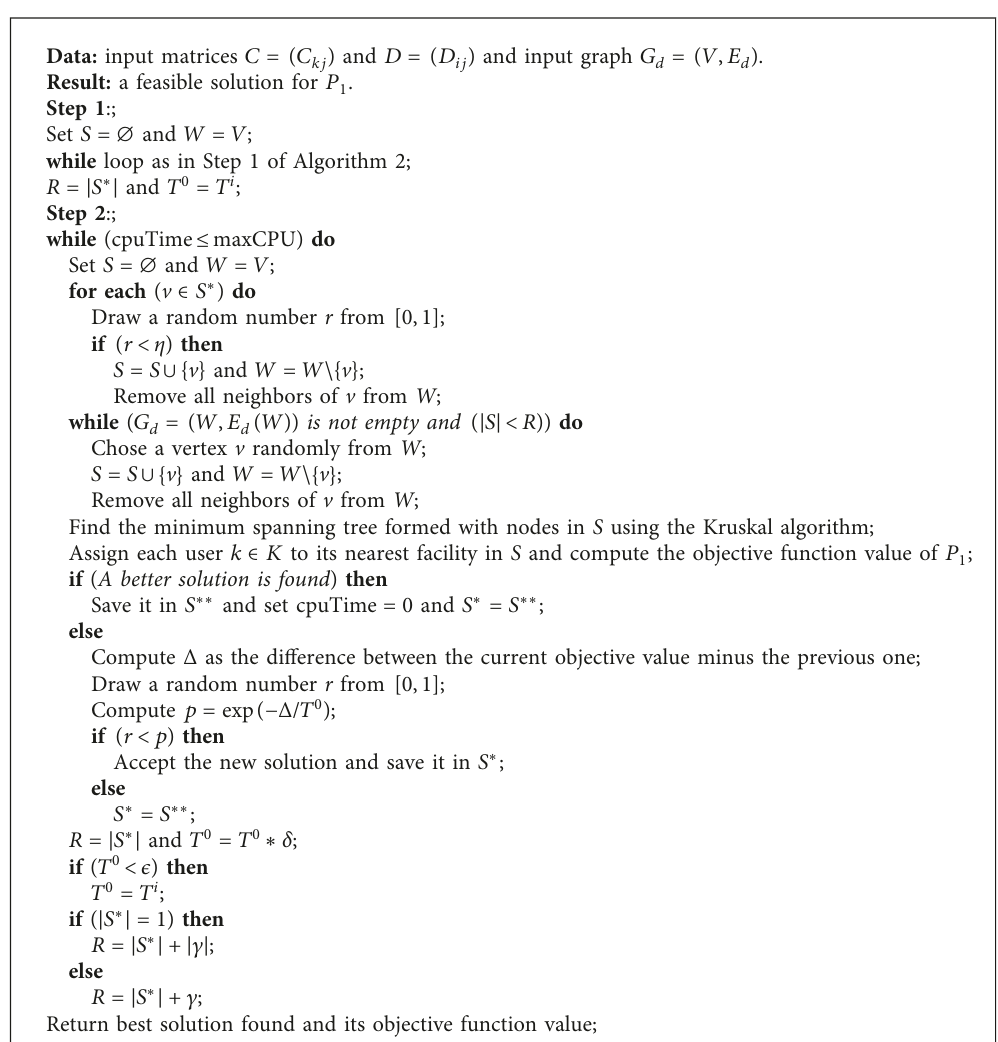
A LGORITHM 3: Simulated annealing-based